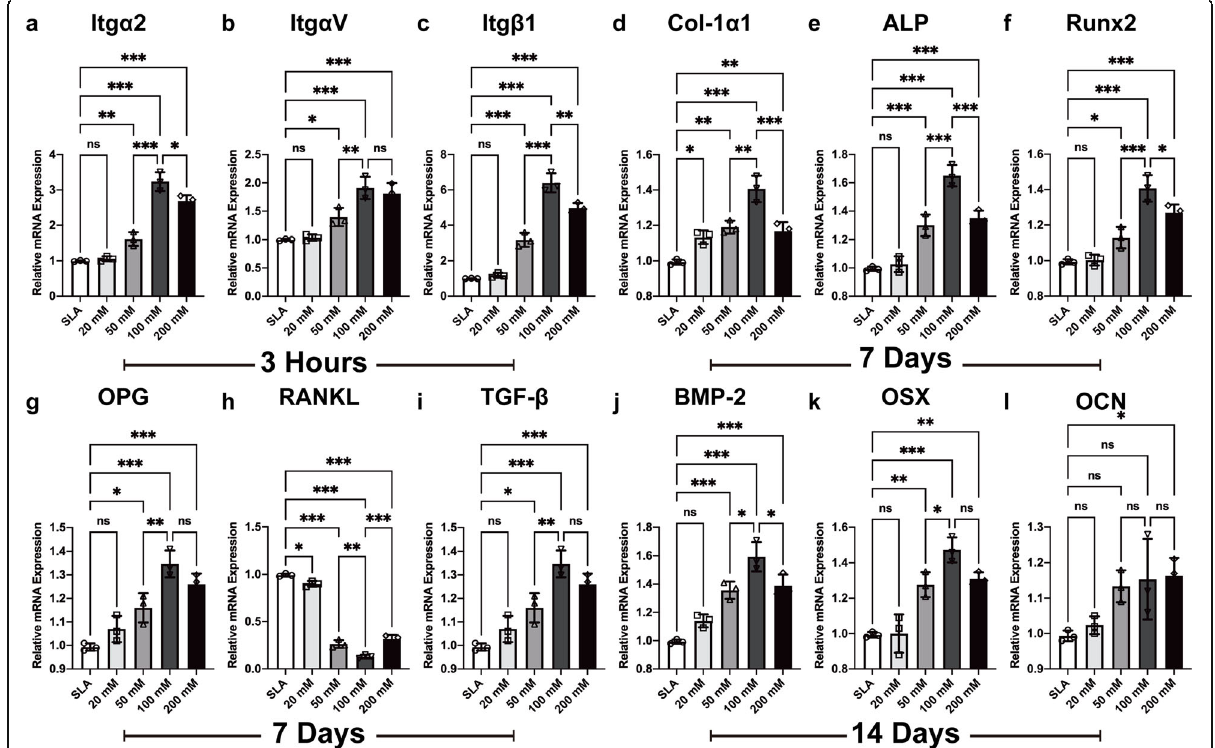
Fig. 10 The mRNA expression of integrin α 2 ( a ), α V ( b ), and β 1 ( c ) at 3 h; Col-1 α 1 ( d ), Runx2 ( e ), ALP ( f ), OPG ( g ), RANKL ( h ), and aTGF- β ( i ) t 7 days; and BMP-2 ( j ), OSX ( k ), and OCN ( l ) at 14 days after BMSC seeding and osteogenic differentiation on SLA discs treated with different concentration of sodium bicarbonate. Data are presented as the mean ± standard deviation ( n = 3, * P < 0.05; ** P < 0.01; *** P < 0.001)